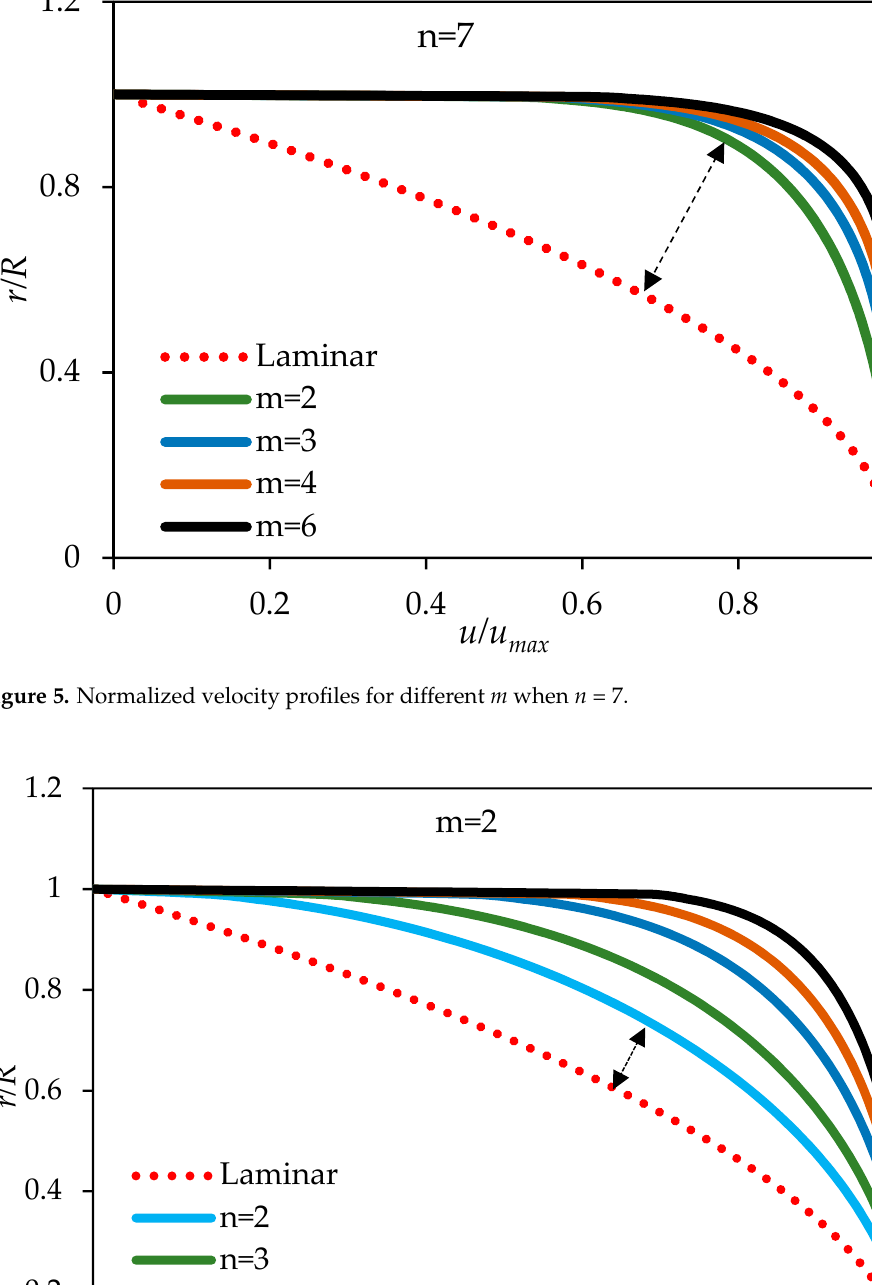
Figure 5. Normalized velocity profiles for different m when n = 7.